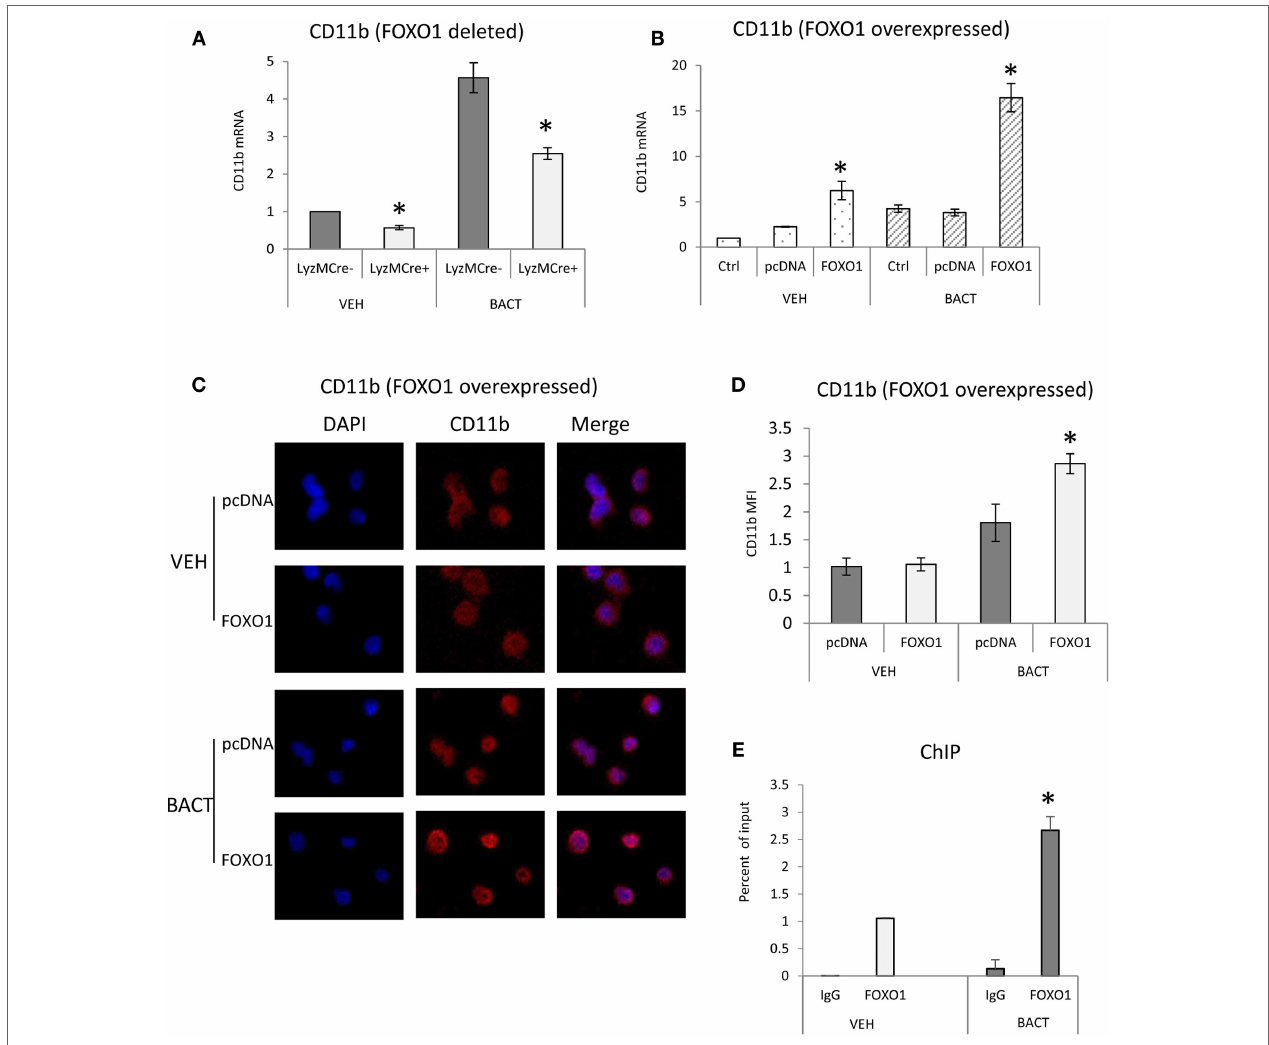
FigUre 5 | FOXO1 regulates CD11b expression. (a) Neutrophils were isolated from FOXO1-deleted LyzM.Cre + FOXO1 L/L and control LyzM.Cre − FOXO1 L/L mice and incubated with Porphyromonas gingivalis . (a) RNA was isolated from neutrophils and CD11b mRNA levels were measured by RT-PCR and normalized to ribosomal protein L32. (B) HL-60 neutrophils were transfected with a plasmid expressing FOXO1 or empty vector alone with or without incubation with bacteria. RNA was isolated from neutrophils and CD11b measured by real-time PCR. (c) HL-60 neutrophils were transfected with FOXO1 expression plasmic or vector alone. Immunofluorescence was carried out using a CD11b specific antibody and DAPI counterstain. Intensity was measured to assess protein levels of CD11b. (D) Cells described in panel C were assessed for mean fluorescence intensity (MFI) to quantify CD11b protein levels. (e) FOXO1 interaction with the CD11b promoter examined by chromatin immunoprecipitation (ChIP) assay using primary murine neutrophils from normal mice. The data are representative of two or three independent experiments and expressed as the mean ± SEM from triplicate samples. *Significant difference between neutrophils from FOXO1-deleted LyzM.Cre + FOXO1 L/L mice and littermate control LyzM.Cre − FOXO1 L/L mice ( P < 0.05). *Significant difference between neutrophils from transfection of FOXO1 vs. empty vector alone ( P <